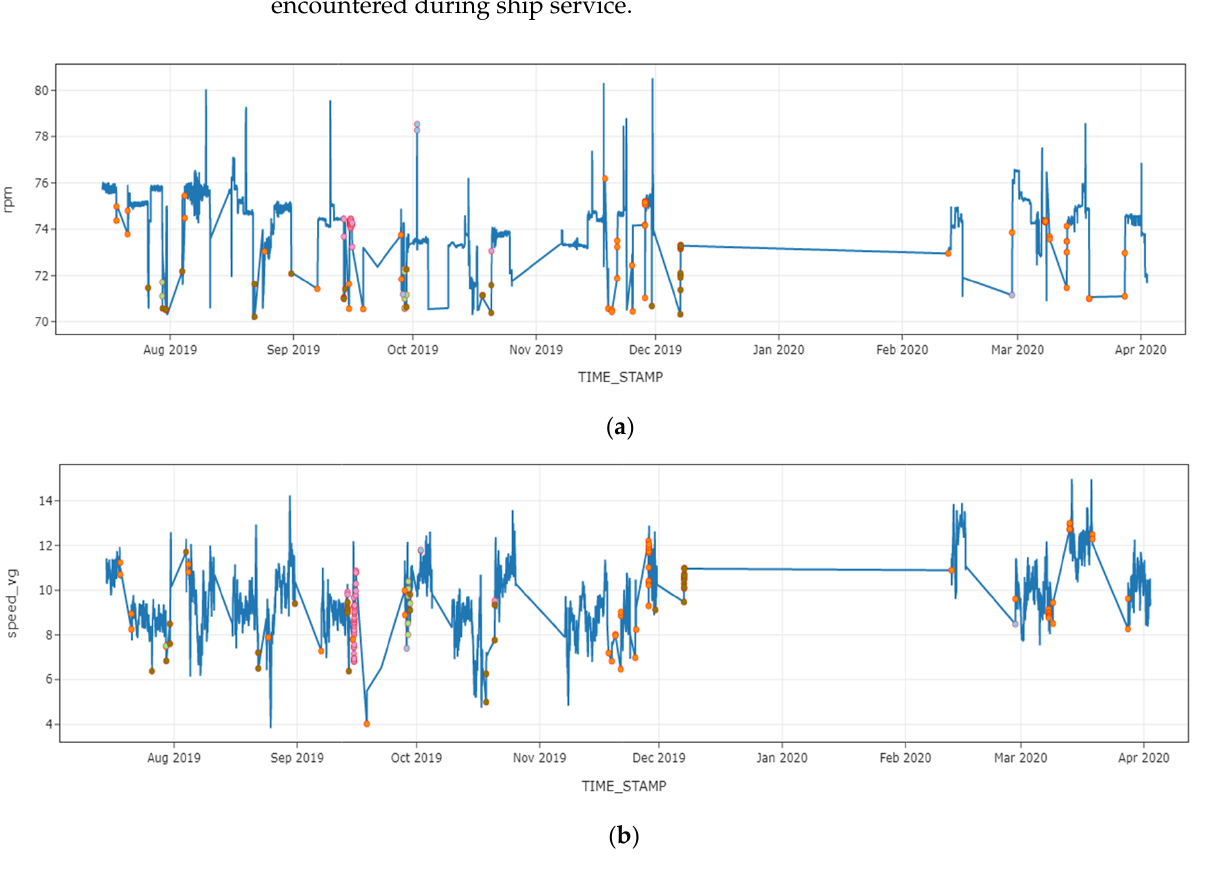
Figure 17. Pressure of lubricant oil inlet vs. RPM cross plot comparison with cluster distribution.